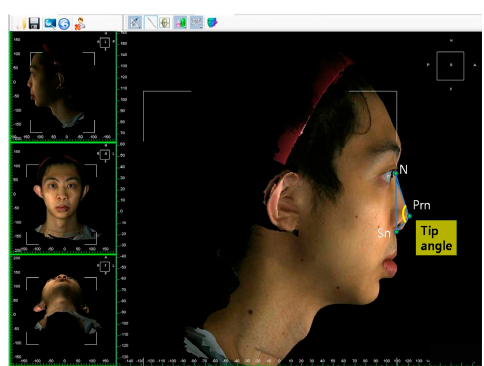
Figure 6. Representation of dome height and columellar height.